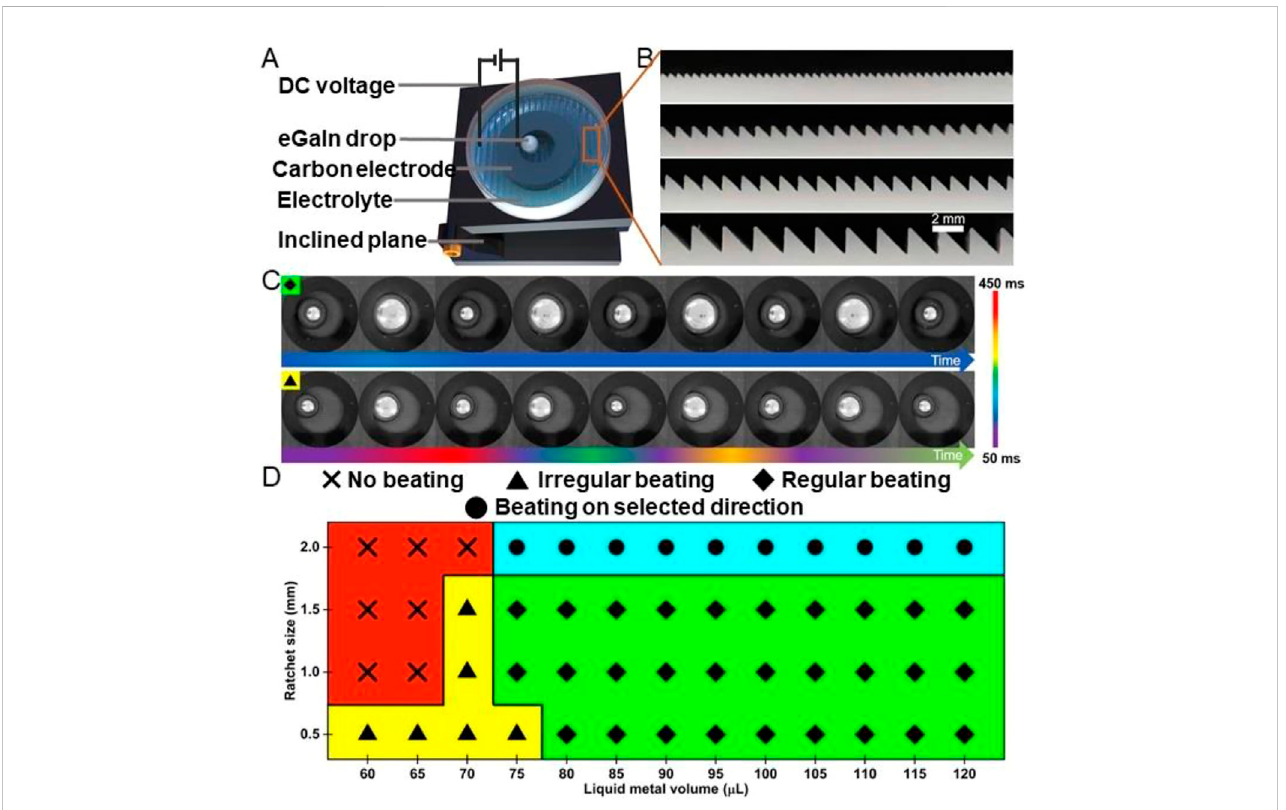
FIGURE 1 Heart beating effect of the eGaIn drop on ratchet substrates. (A) Schematic illustration of the experiment device. (B) Cross-section images of ratchet substrates with an isosceles right-angle shape (the sawtooth sizes are 0.5, 1.0, 1.5, and 2.0 mm). (C) Diagrammatic representation of four cycles of 120